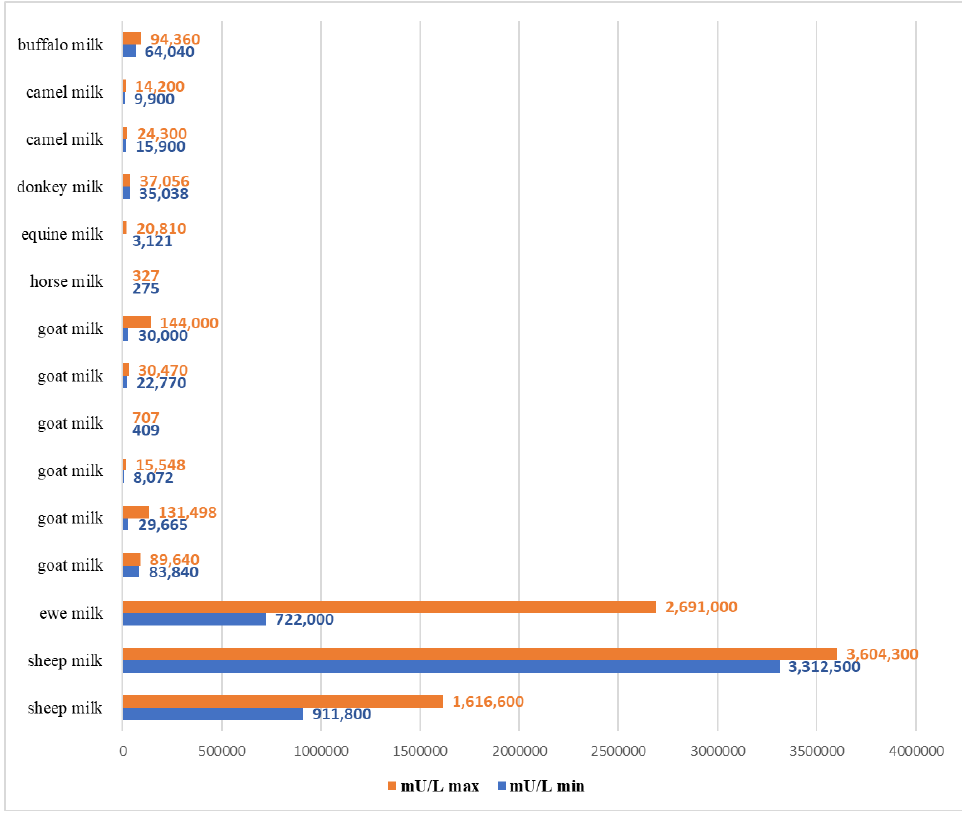
Figure 3. ALP activities in non-cow raw milks [13,14,22,25,27,30,32,38,39,41].